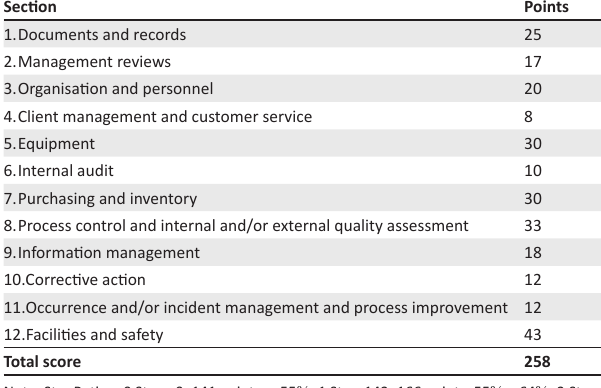
TABLE 1: Sections of the WHO AFRO SLIPTA checklist and star